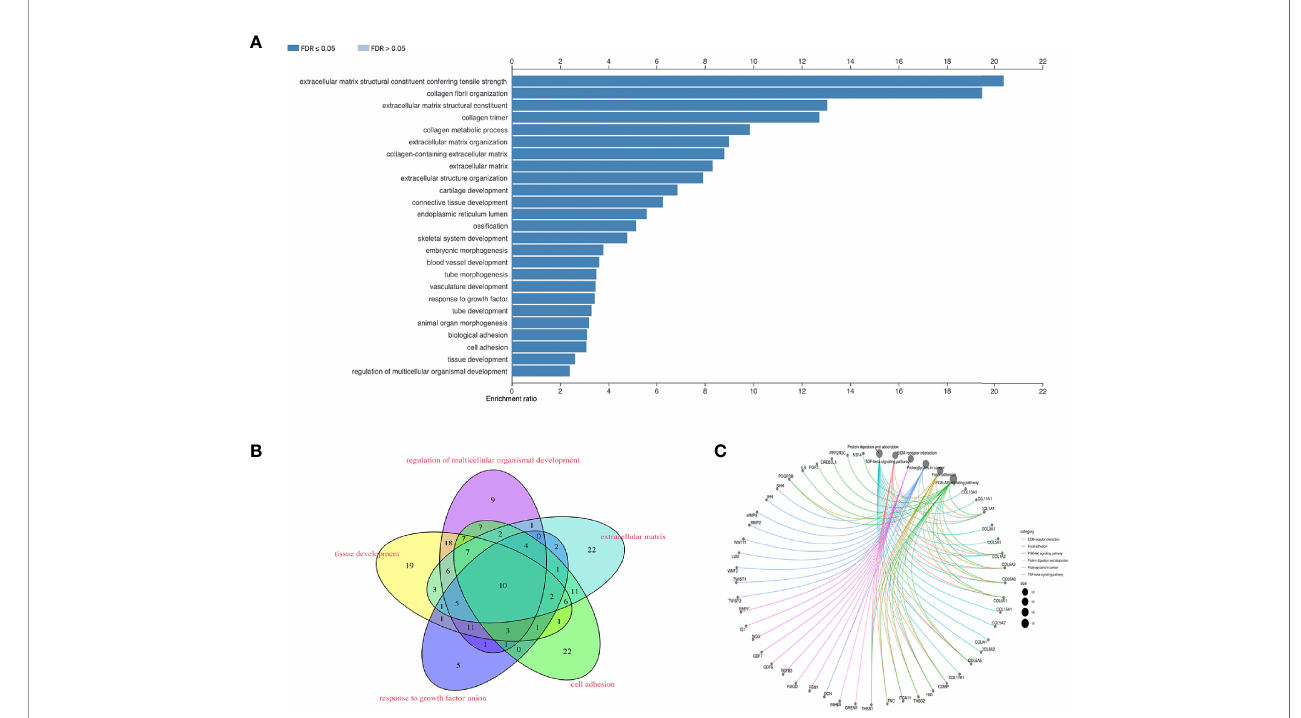
FIGURE 3 | To screen for functionally enriched gene signatures associated with BCa invasion, progression, metastasis and poor prognosis. (A) The 395 co- expressed DE-mRNA enriched GO terms are mainly (FDR < 0.05) collagen fi ber organization, extracellular matrix organization, vascular development, response to growth factors, bioadhesion, and tissue development. (B) Enrichment of biological processes such as extracellular matrix, tissue development, response to growth factors, cell adhesion and developmental regulation of multicellular organisms. (C) KEGG analysis of 395 co-expressed